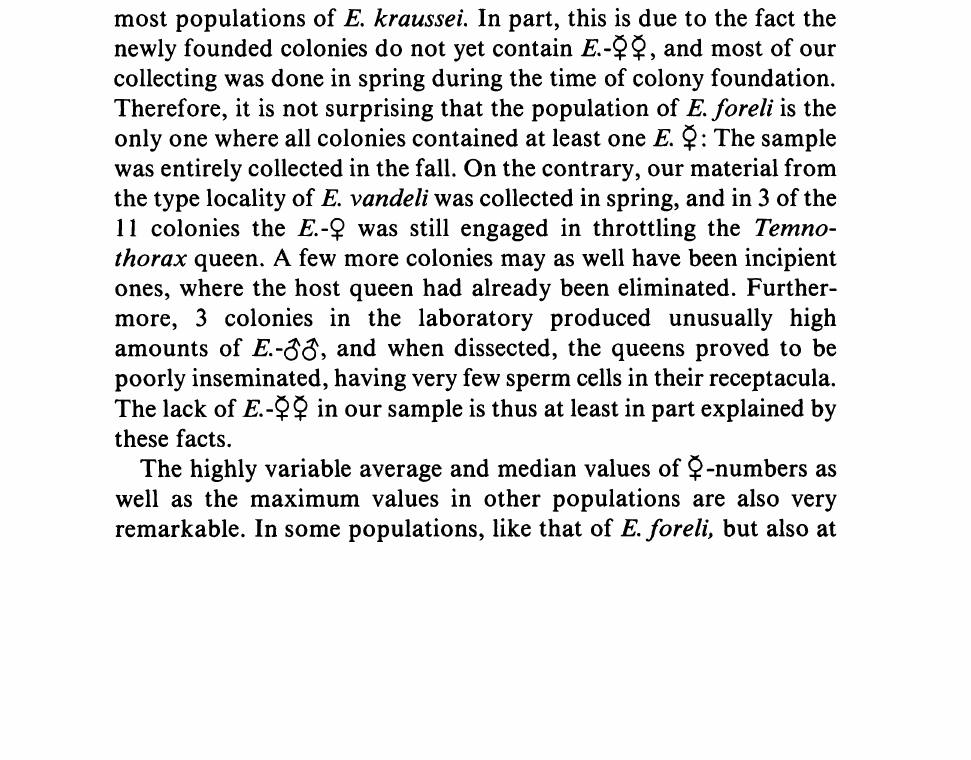
Fig..6: Karyotypes of a: Epimyrma kraussei from pop. no. 5b (Aude, S’France) and b: Epimyrma ravouxi from pop. no. 12a (Lago di Como,